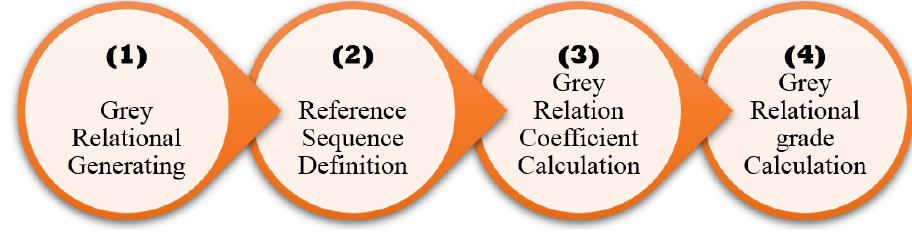
Figure 3. Coordinate measuring machine: ( a ) workpiece setting on CMM, ( b ) dimensional meas ‐ urement of machined surfaces.